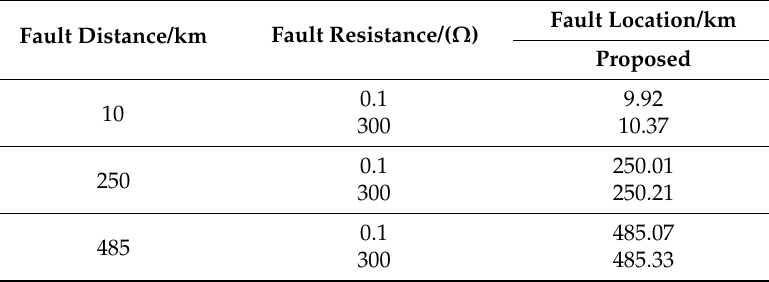
Table 6. The fault location results by 90 ◦ by fault angle.